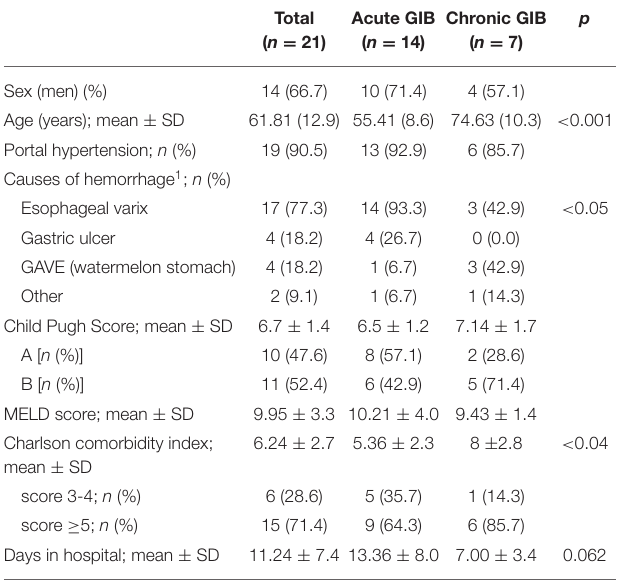
TABLE 2 | Patients admitted to the hospital: clinical characteristics ( n = 21 patients) and blood transfusions plus FCM treatment ( n = 23